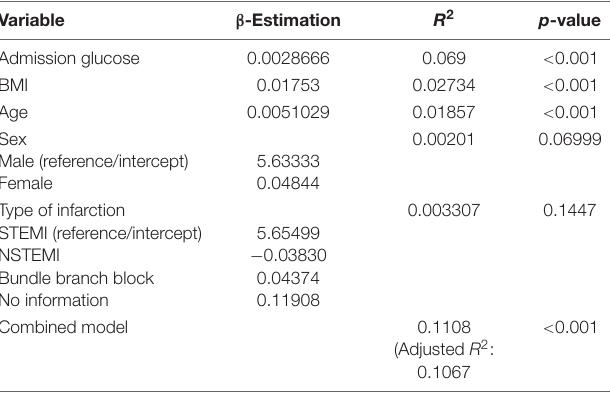
TABLE 3 | Linear regression models with the dependent variable